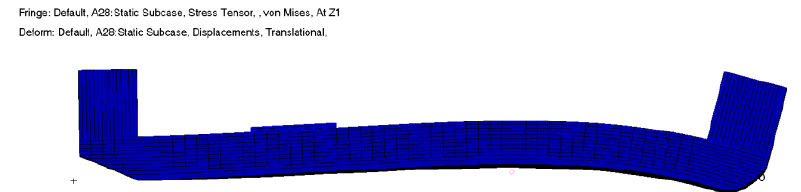
Figure 23. Stress cloud map of the ship at high tide level on the day of the incident.